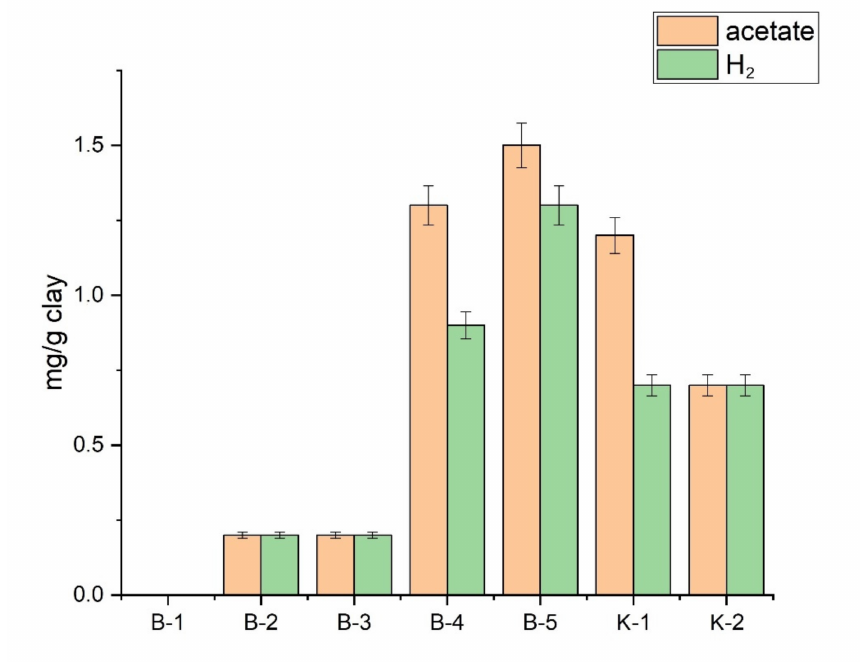
Figure 1. Sulfide content in clay samples after 1-month cultivation with acetate or hydrogen as electron